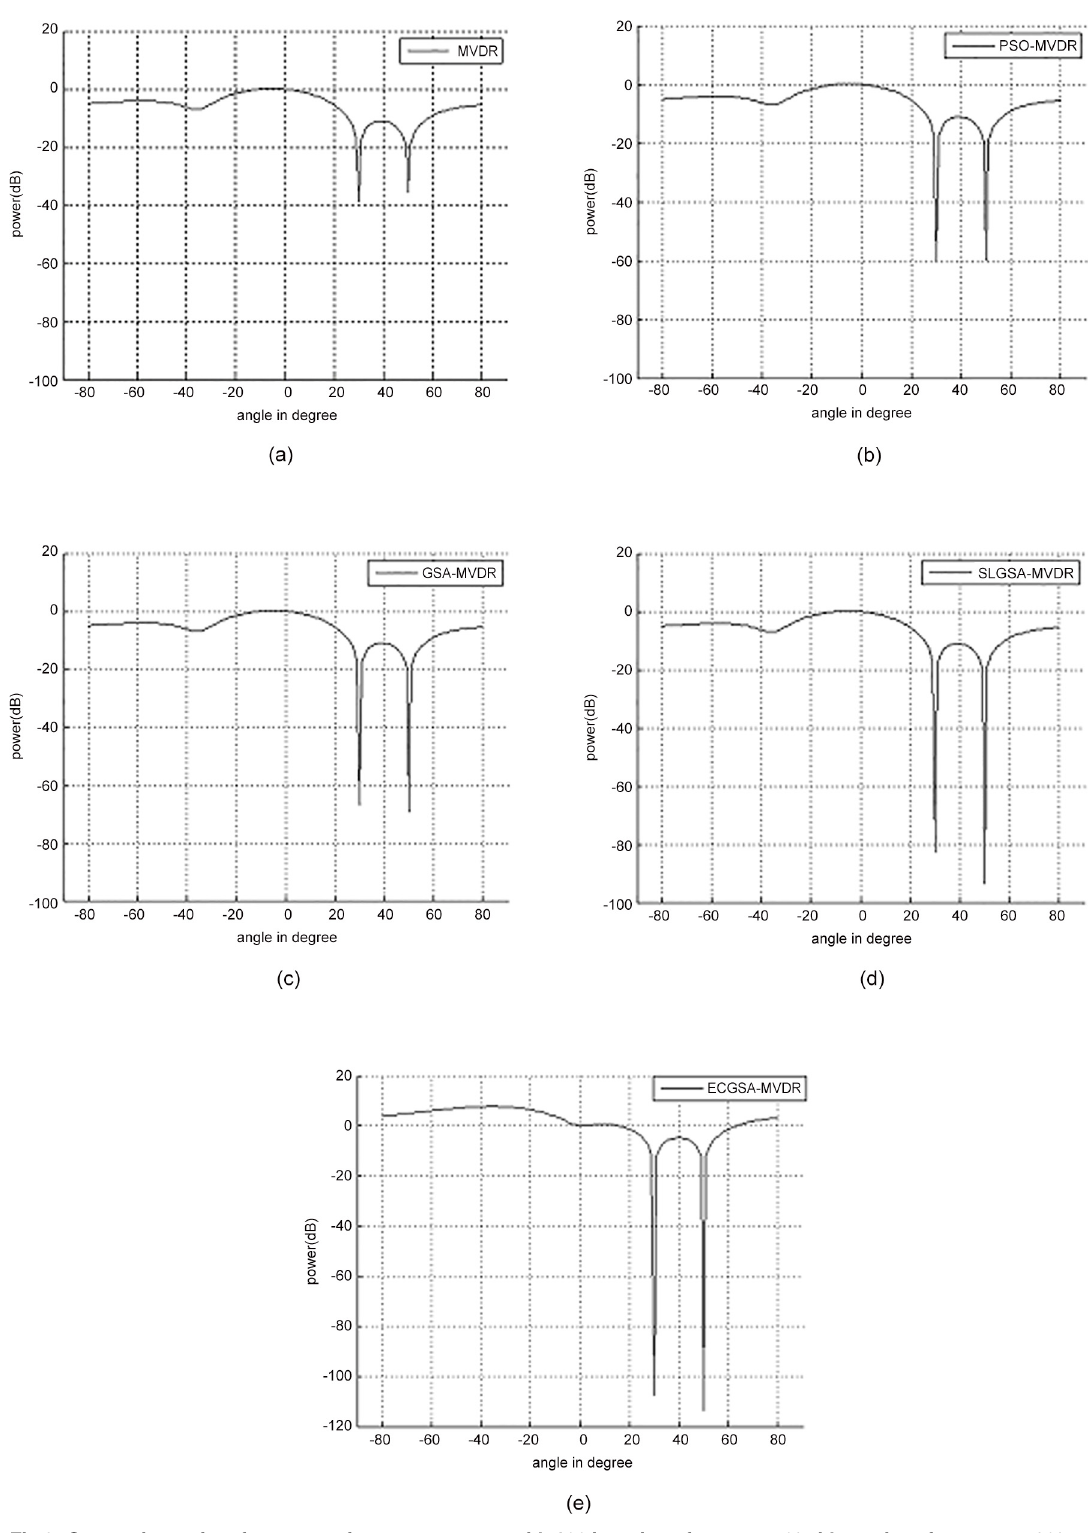
Fig 8. Comparison of performance of power response with 100 iterations for user at 0°with two interferences at 30° and 50°. (a) MVDR, (b) PSO-MVDR, (c) GSA-MVDR, (d) SLGSA-MVDR [28] and (e) ECGAS-MVDR.